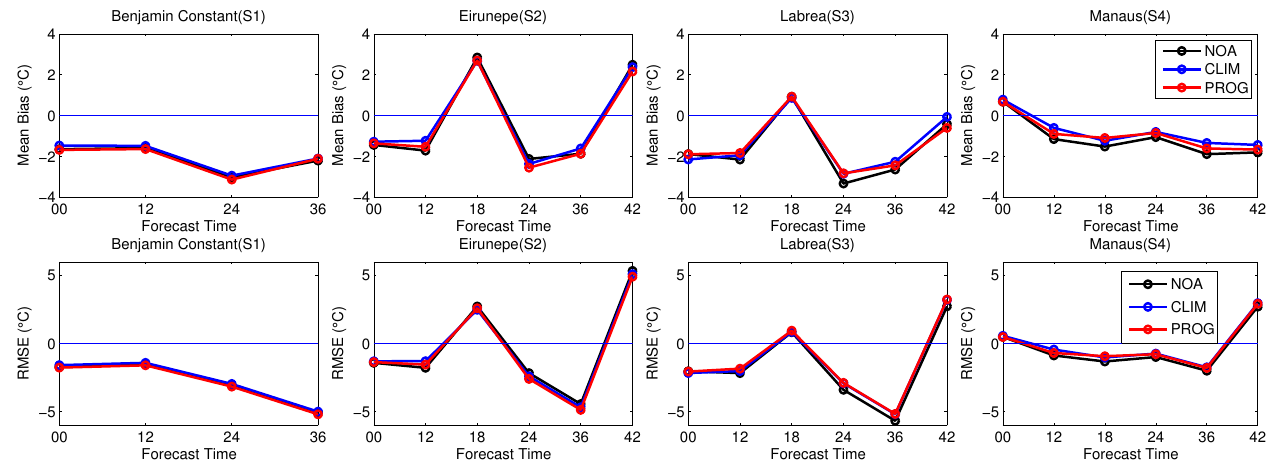
Figure 9. Mean bias and RMS error of modelled temperature at S1, S2, S3 and S4 locations (Fig. 1), averaged over the whole period.